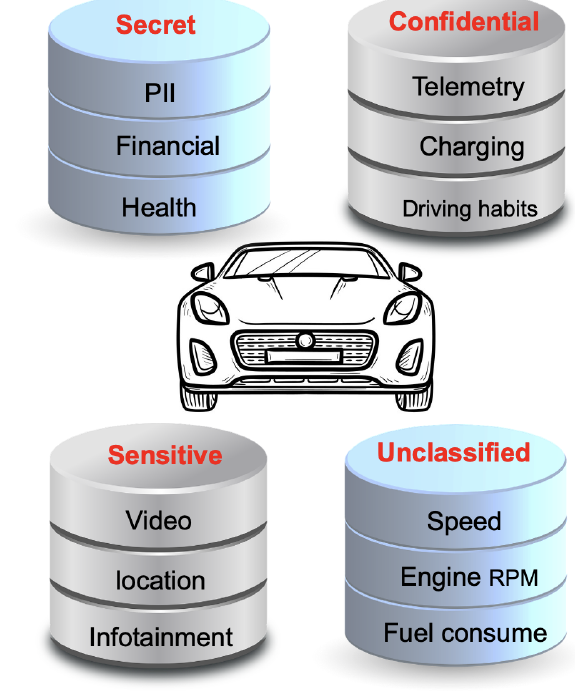
Figure 7. Visualization of data